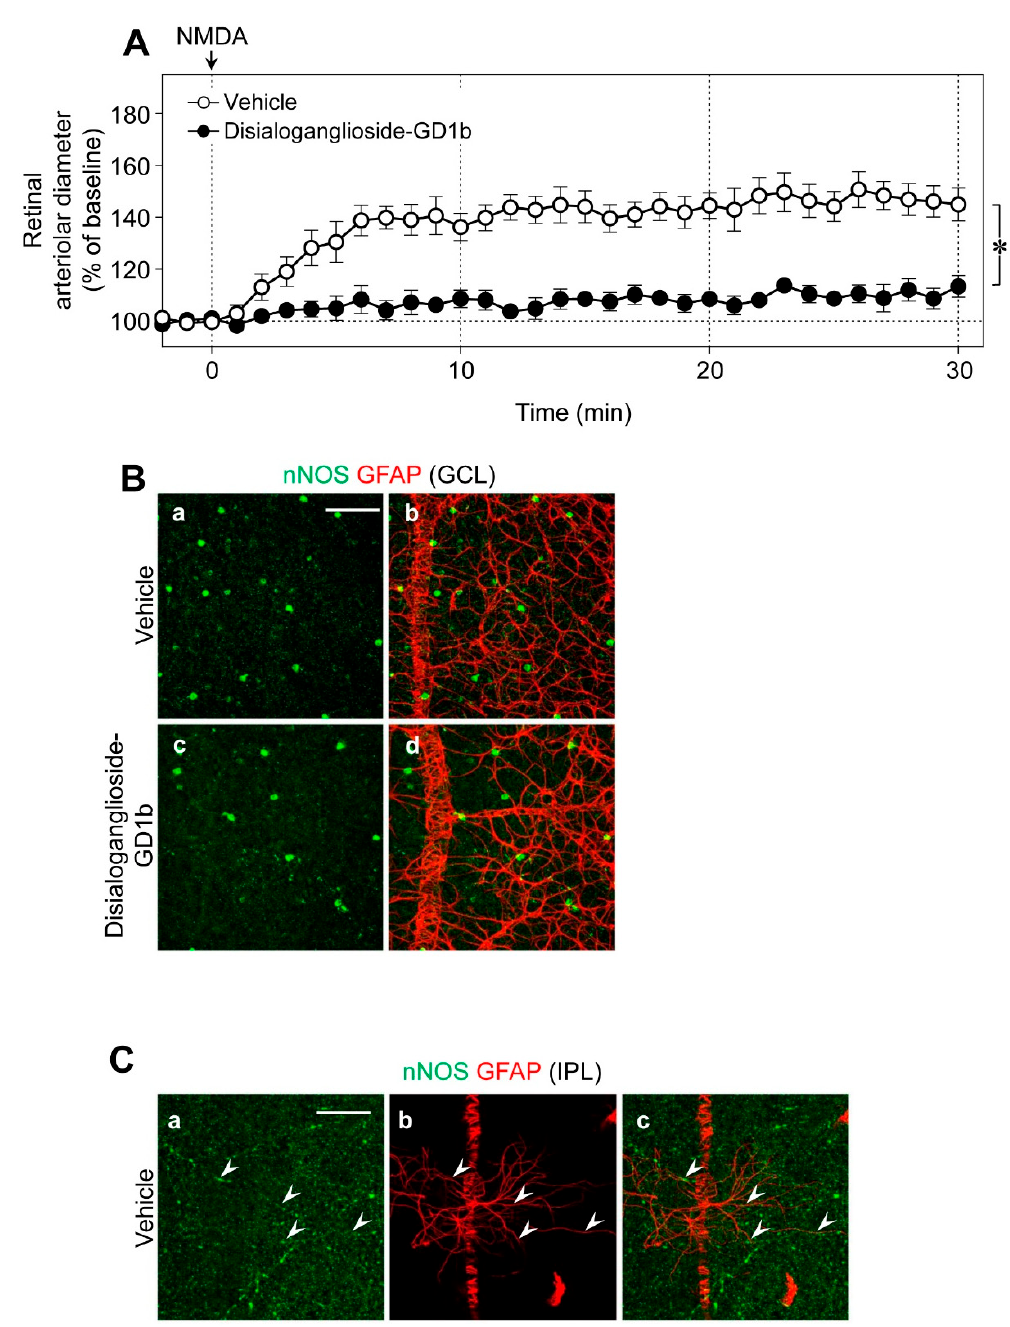
Figure 5. E ff ects of disialoganglioside-GD1b on the retinal vasodilation induced by intravitreal injection of NMDA and nNOS- and glial fibrillary acidic protein (GFAP)-positive positive cells. ( A ) NMDA (6 nmol)-induced changes in the retinal arteriolar diameter in the presence of disialoganglioside-GD1b (15 nmol) or the vehicle. Each point with a vertical bar represents the mean ± SE from five to seven animals. * p < 0.05. ( B , C ) Confocal microscopy images of retinal flat-mounts labeled with anti-nNOS and anti-GFAP antibodies. In panel ( C ), arrowheads indicate that nNOS-positive fibers were closely associated with the processes of GFAP-positive astrocytes. Scale bars: ( B ) 100 µ m in a (applies to b – d ) and ( C ) 50 µ m in a (applies to b , c ). GCL, ganglion cell layer; IPL, inner plexiform layer.